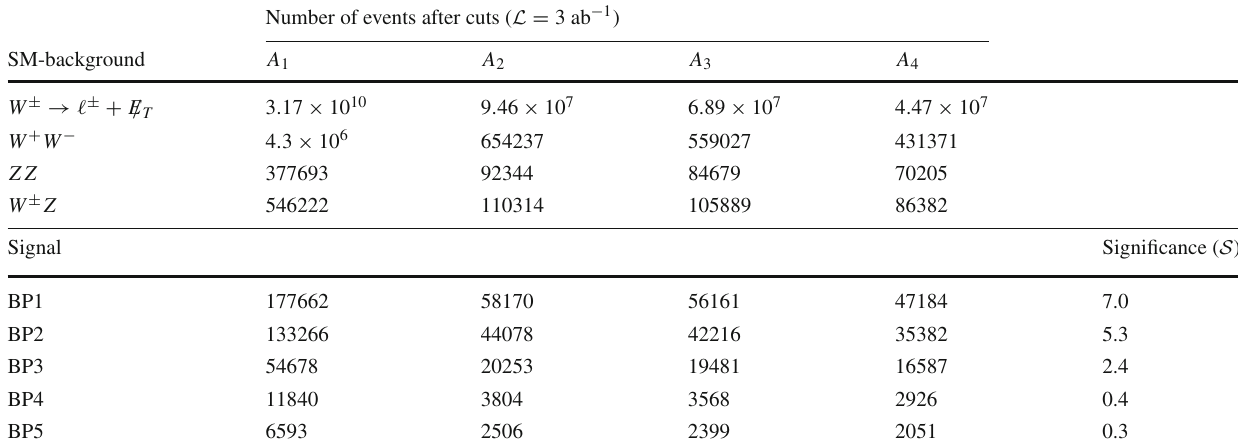
Table 6 The cut-flow for signal and backgrounds along with the significances for BP1, BP2, BP3, BP4 and BP5 at 14 TeV HL-LHC for 3 ab − 1 integrated luminosity for the pp → 1 (cid:3) + E T / channel Number of events after cuts ( L = 3 ab − 1